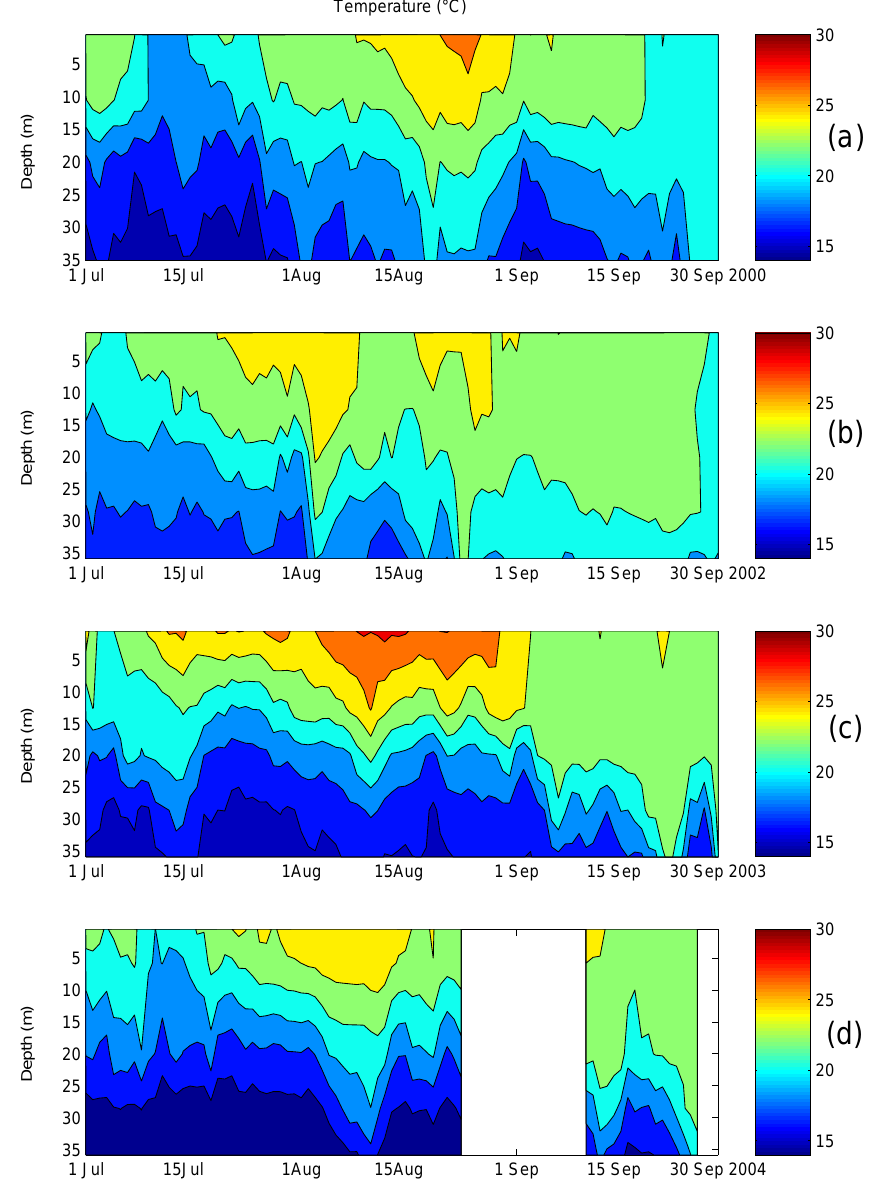
Fig. 3. Temperatures ( ◦ C) from the surface to a depth level of 35m in summer 2000 (a) , 2002 (b) , 2003 (c) , and 2004 (d) . Colour bars in ◦ C are shown on the right and contour lines spaced 2 ◦ C apart are indicated in the